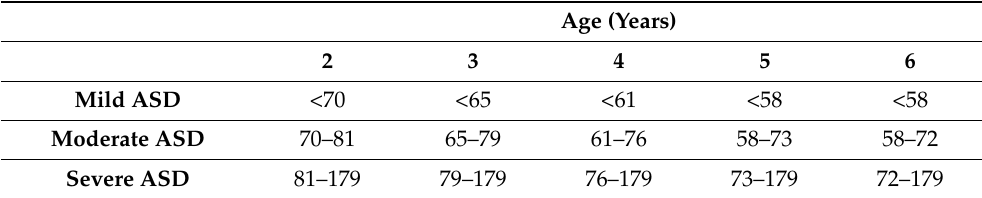
Table 9. Approximate relationship between the ATEC total score, age, and ASD severity. At any age, a greater ATEC score indicates greater ASD severity.